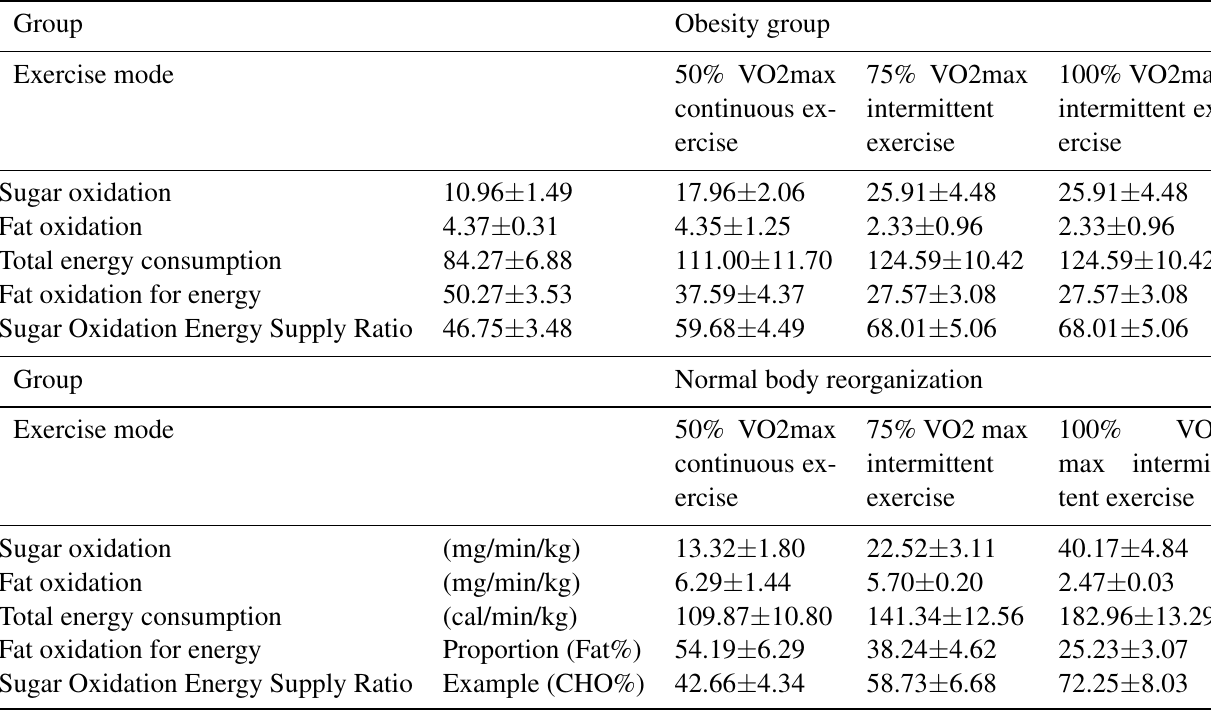
Table 3 Comparison of substrate metabolism and energy consumption during exercise period (30min) between obesity group and normal body recombination.